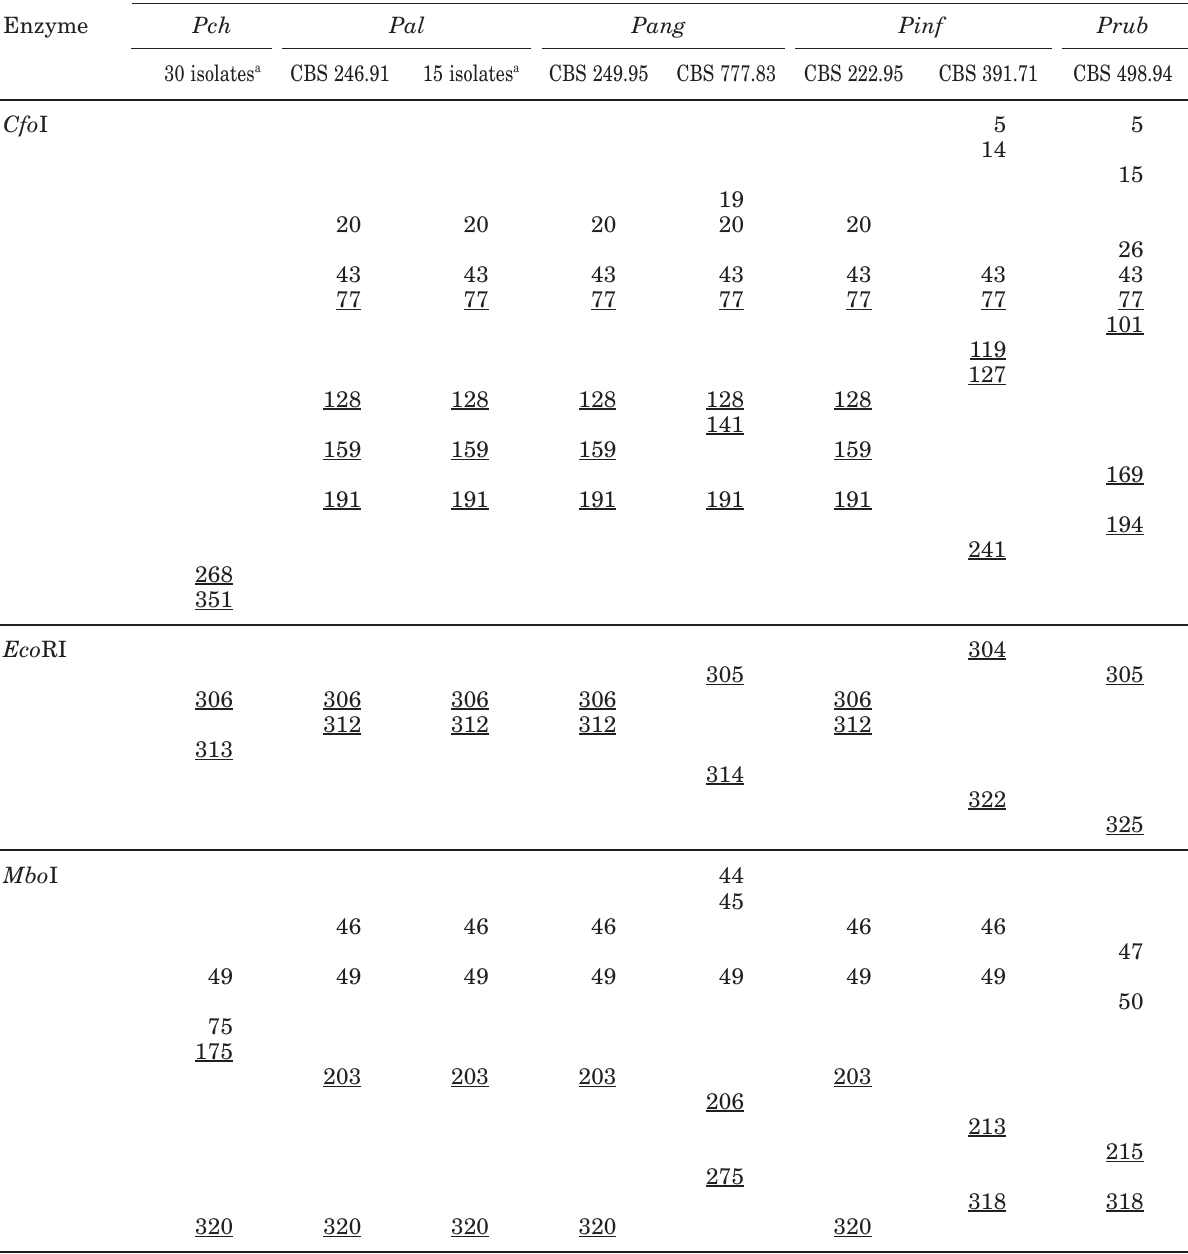
Table 3. Estimated restriction fragments sizes (base pairs) following digestion of ITS region from five Phaeoacremo- nium species with seven restriction enzymes. Fragments which were visible on agarose gel are shown underlined; the remaining fragments are inferred from sequence data for the ITS region (see Fig. 2). Abbreviations: Pch ,